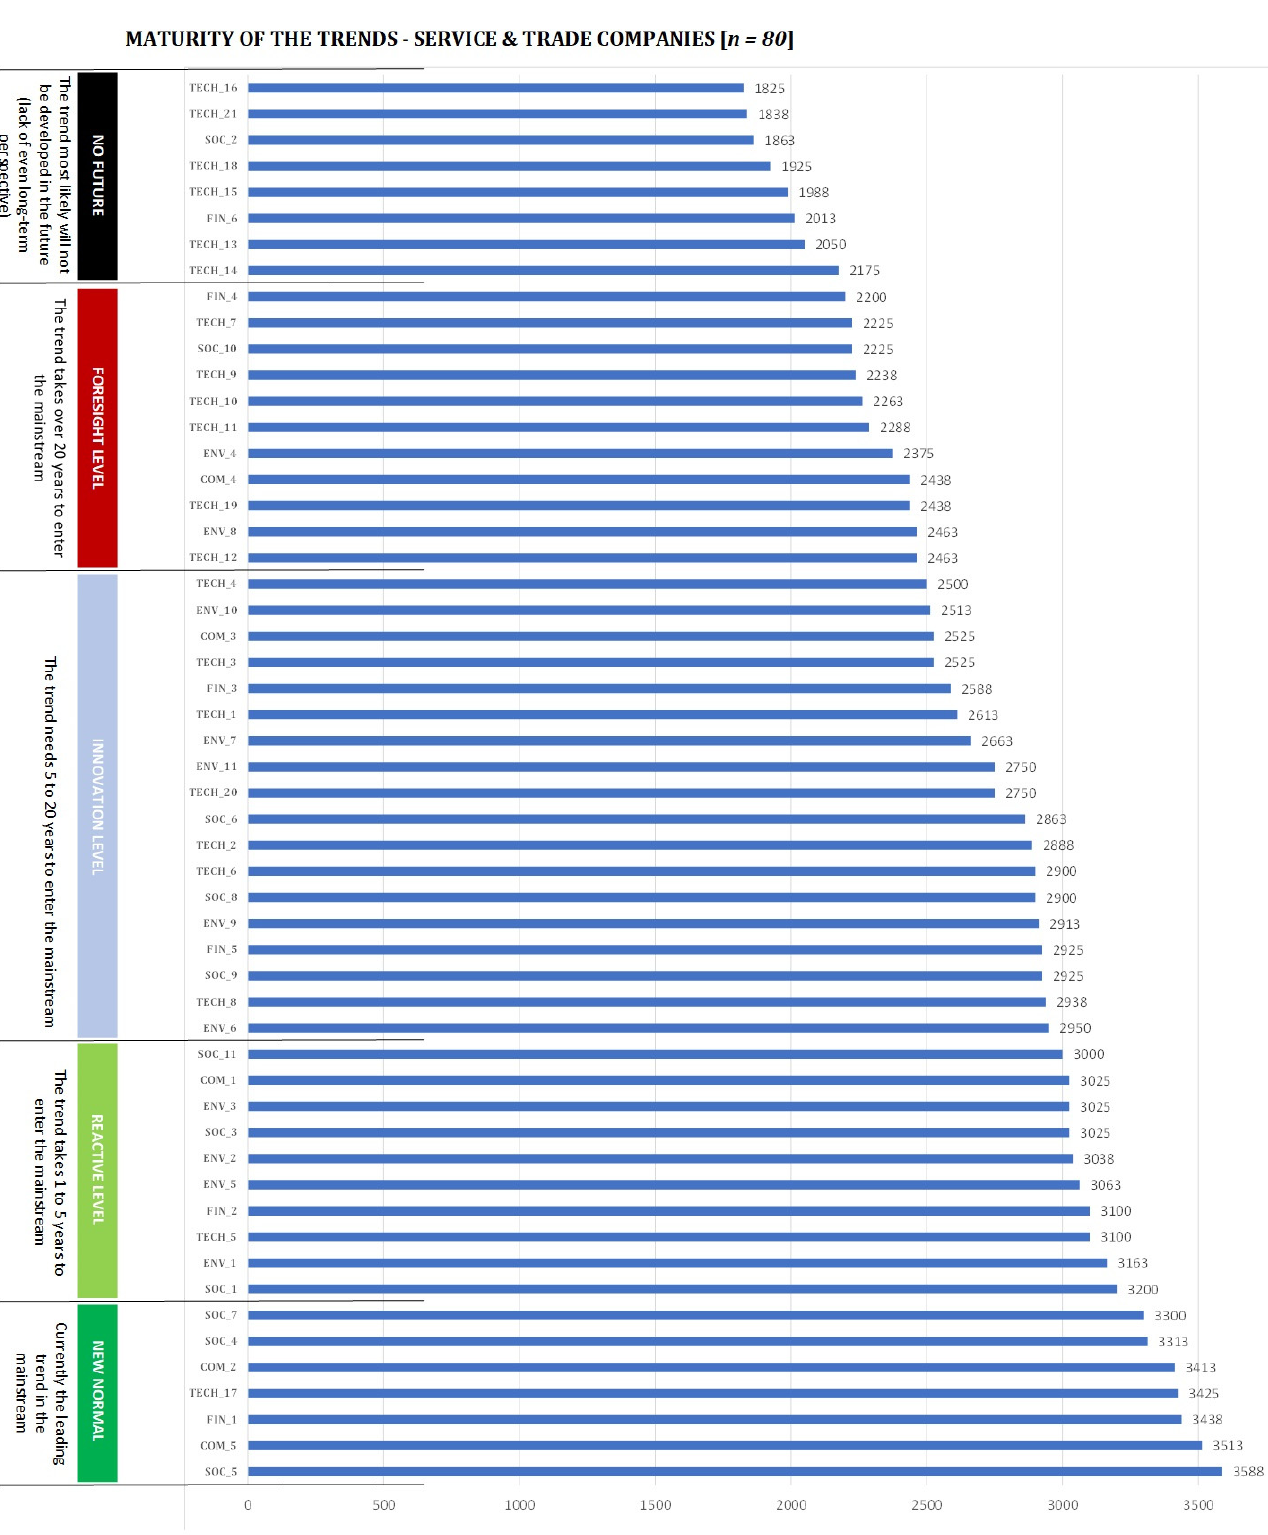
Figure 4. Map of Maturity of S.T.F.E.C. SMART management trends—S&T companies. Source: Own elaboration.